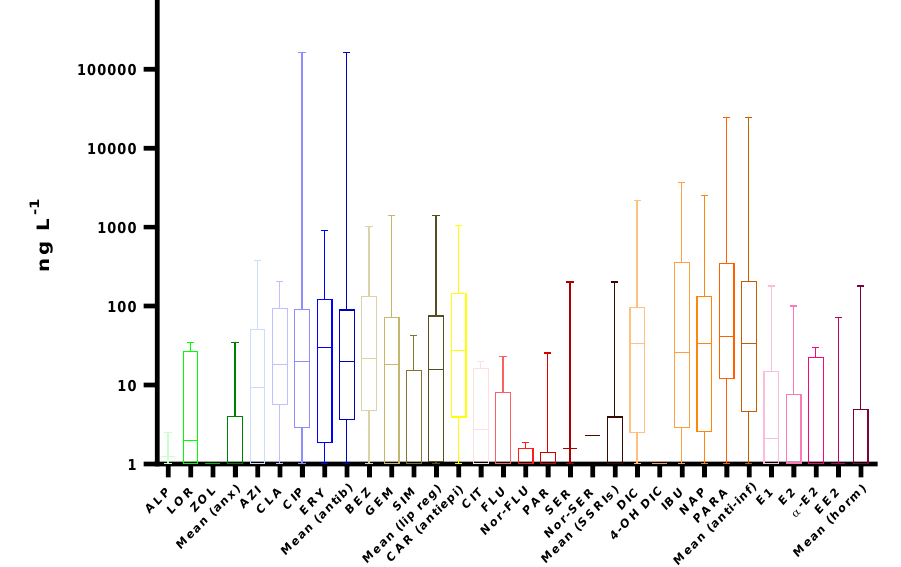
Figure 4. Boxplots with median, maximum and minimum average concentrations of pharmaceuticals in surface waters. Anx—anxiolytics, Antib—antibiotics, Lip reg—lipid regulators, Antiepi—antiepileptics, in surface waters. Anx — anxiolytics, Antib — antibiotics, Lip reg — lipid regulators, Antiepi — SSRIs—selective serotonin reuptake inhibitors, Anti-inf—anti-inflammatories, Horm—hormones antiepileptics, SSRIs — selective serotonin reuptake inhibitors, Anti-inf — anti-inflammatories, Horm —